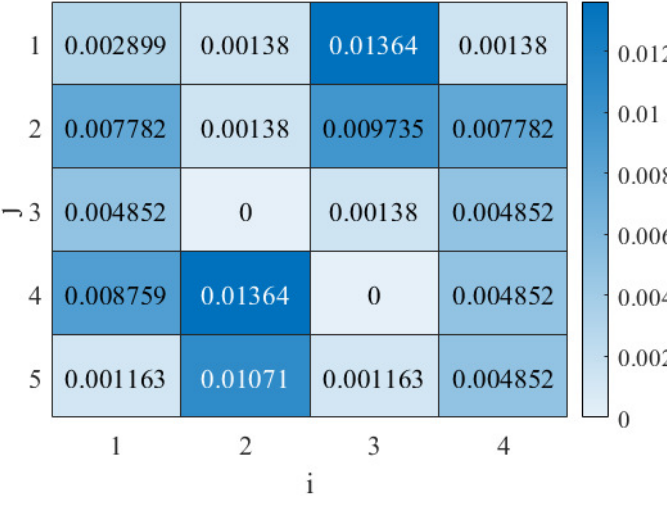
, for the probabilities P ( x j i ,2